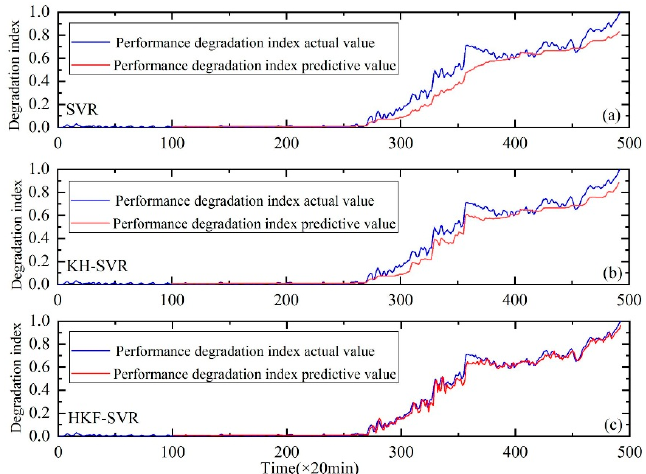
Figure 5. Performance degradation prediction of bearing 1. ( a ) is the result of SVR, ( b ) is the result of SVR with parameters optimized by the KH algorithm and ( c ) is the result of HKF–SVR with parameters optimized by the KH algorithm.